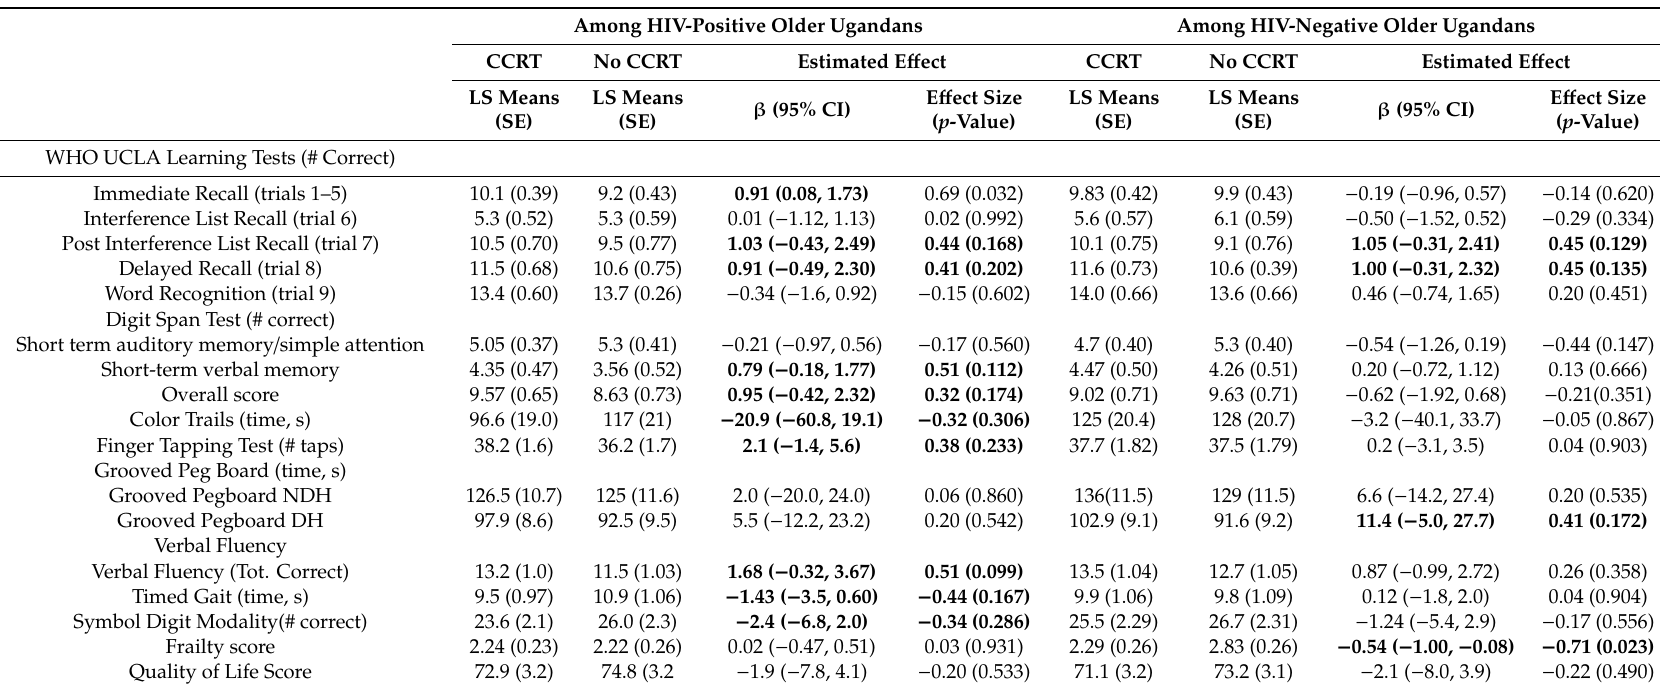
Table 4. CCRT Intervention-Related Change in Cognitive and QOL outcomes Among Older Ugandans with and without HIV